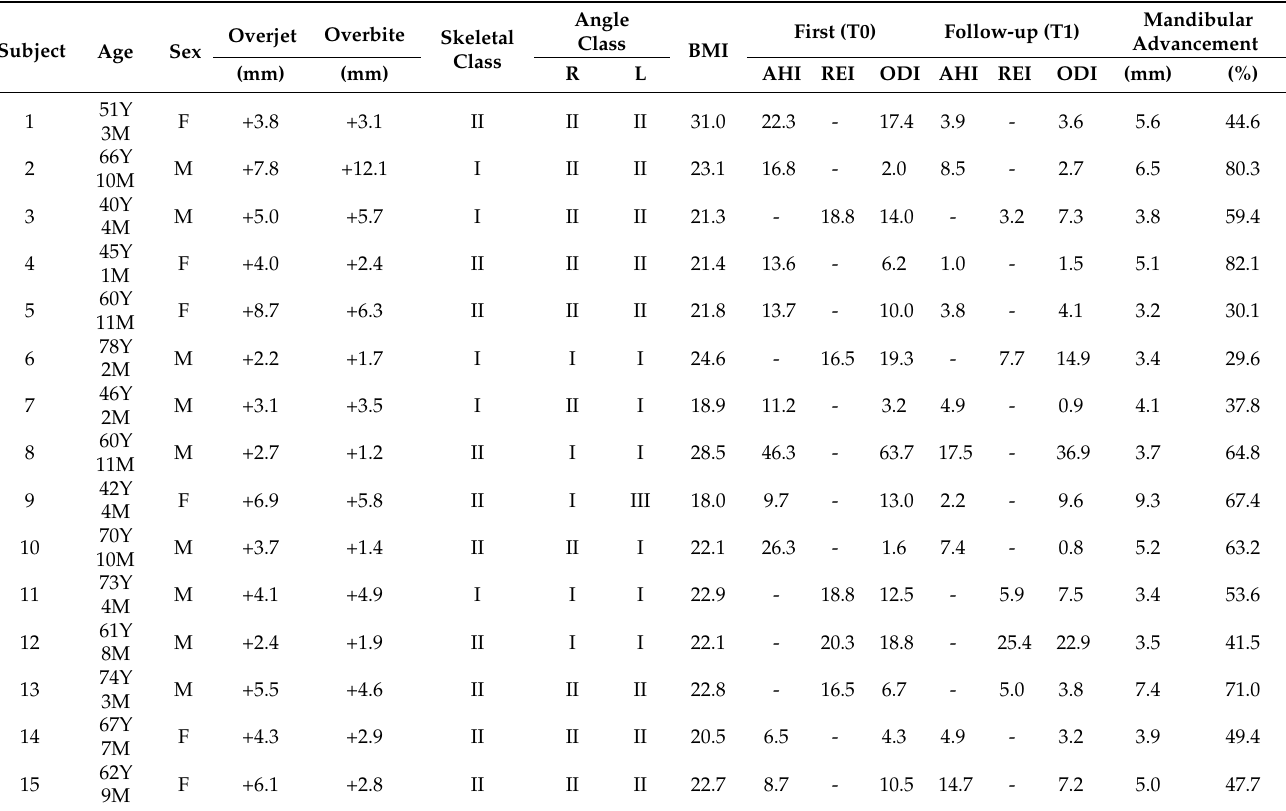
Table 6. Each patient’s respective